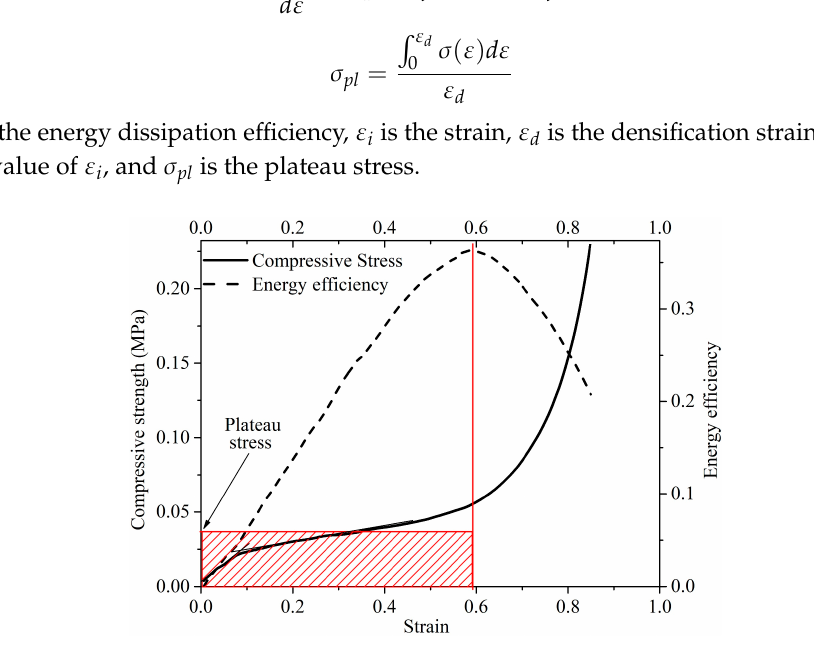
Figure 3. Illustration of energy efficiency method.